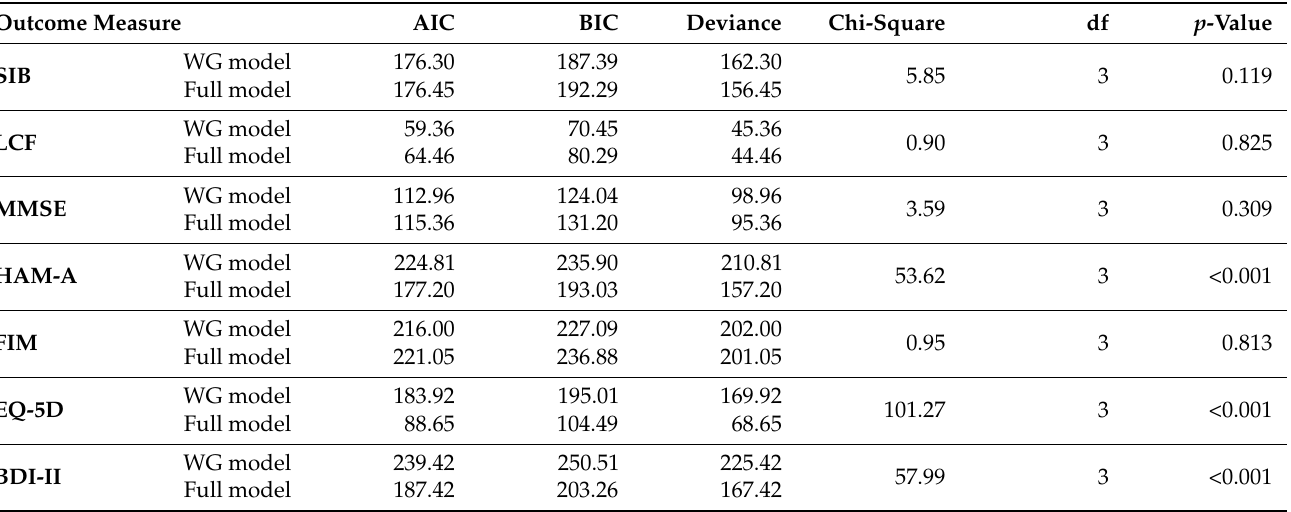
Table 2. Comparison between the full model (full model) and model without ‘group’ as fixed effect (WG model), for each outcome